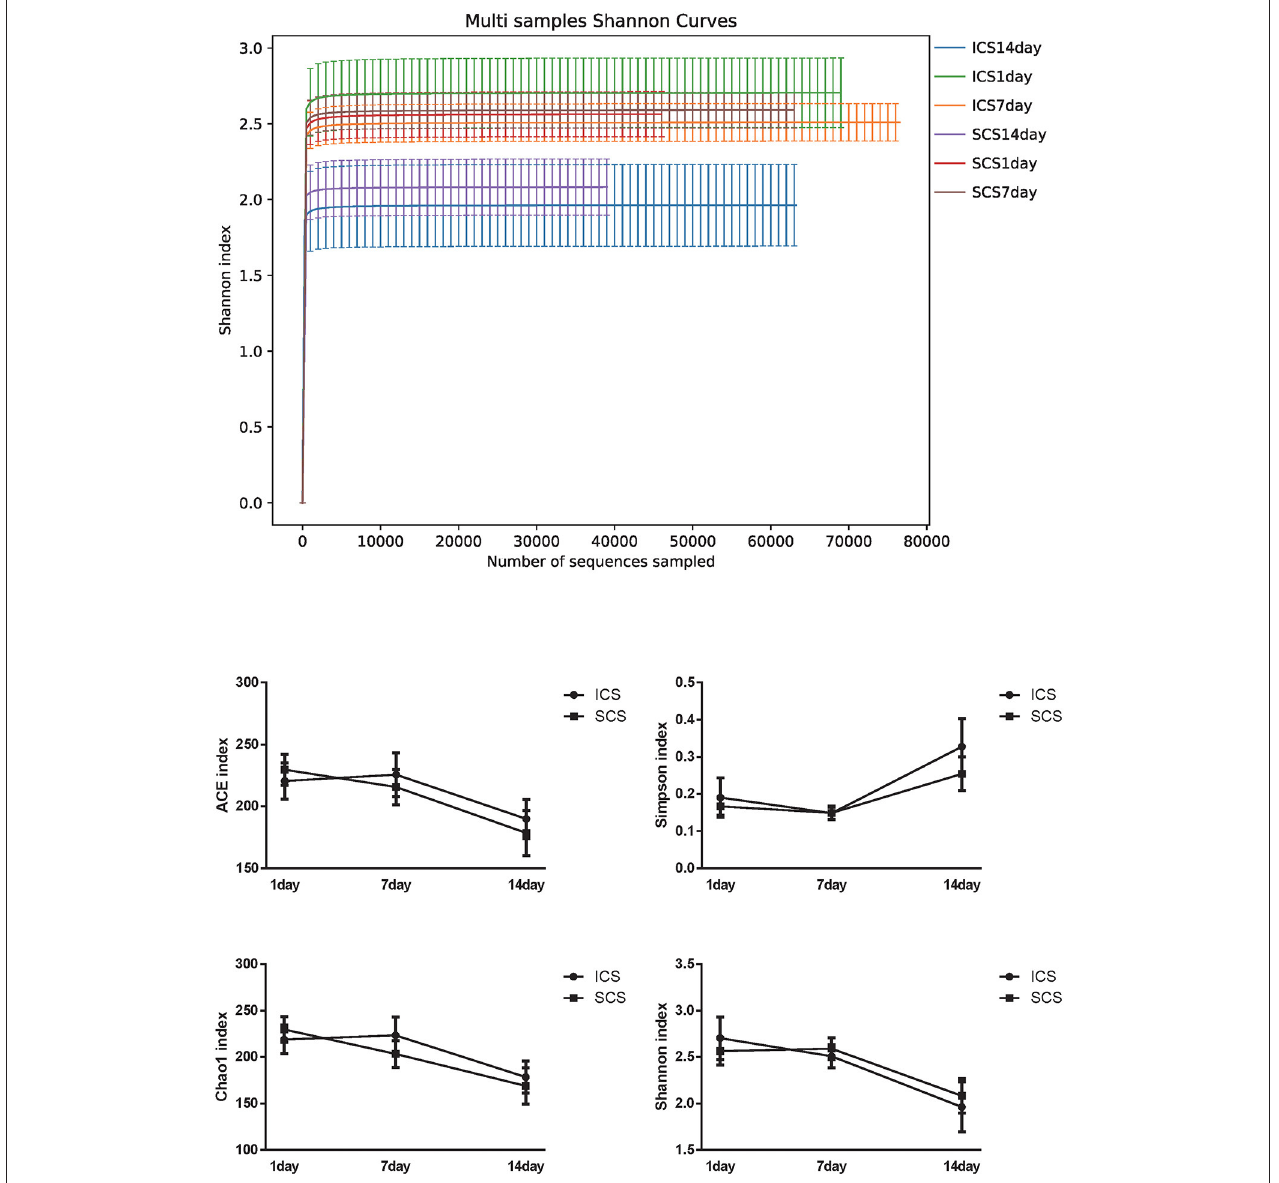
FIGURE 8 | Alpha diversity in ICS vs. SCS. Shannon index of each group and statistical analysis of the ACE index, Chao1 index, Shannon index, and Simpson index ( p < 0.05). After 14 days of treatment, the ACE index of the SCS group was significantly lower than the first day of treatment, and the Shannon index of the SCS group was significantly lower than the first day of treatment. The Shannon index of the ICS group was also significantly lower than the first day of treatment. No differences were found between the two groups at the same treatment time ( p <